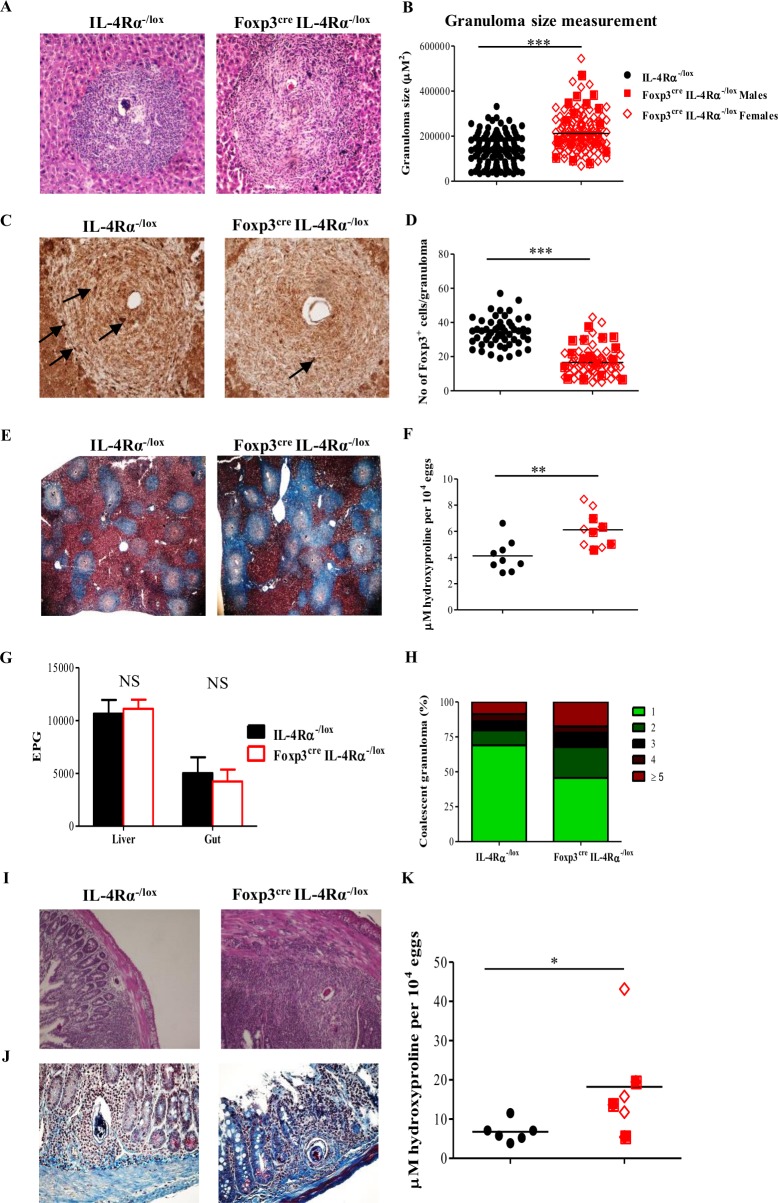
Deletion of IL-4Rα on Foxp3+ Treg cells impairs the control of fibrogranulomatous inflammation during schistosomiasis.(A) Representative HE staining of liver sections from mice infected with Sm for 8 wk (original magnification 100×). (B) Liver granuloma size. Granuloma size was determined from (A) by using a computerized morphometric analysis program (NIS elements by NIKON) by measuring 100 granulomas/group. (C) Representative Foxp3 Treg cells’ infiltration within liver granuloma 8 wk post Sm infection (original magnification 100×) of IL-4Rα−/Lox and Foxp3Cre IL-4Rα−/Lox mice. Thin arrows point to Foxp3+ cells. (D) Quantification of the number of Foxp3+ cells per each granuloma from (C). (E) Representative CAB-stained liver sections from Sm-infected mice (original magnification 40×). (F) Liver hydroxyproline content measured by colorimetry 8 wk post infection. (G) Liver and gut egg burden 8 wk post infection. (H) Bar graphs showing the number of coalescent granulomas. (I) Representative HE staining of gut sections 8 wk post infection (original magnification 100×). (J) Representative CAB-stained gut sections 8 wk post infection (original magnification 200×). (K) Gut hydroxyproline content 8 wk post infection. Results are representative of two independent experiments with 6–10 mice/group. Data are expressed as mean ± S.E.M. NS, P > 0.05; * P < 0.05, ** P < 0.001, *** P < 0.0001 by two-tailed unpaired Student t test and one-way ANOVA with Bonferroni posttest analysis. Underlying data can be found in S1 Data. CAB, chromotrope aniline blue; EPG, egg per gram; Foxp3, forkhead box P3; HE, hematoxylin–eosin; IL-4Rα, interleukin-4 receptor alpha; NS, not significant; Sm, S. mansoni; Treg, regulatory T.